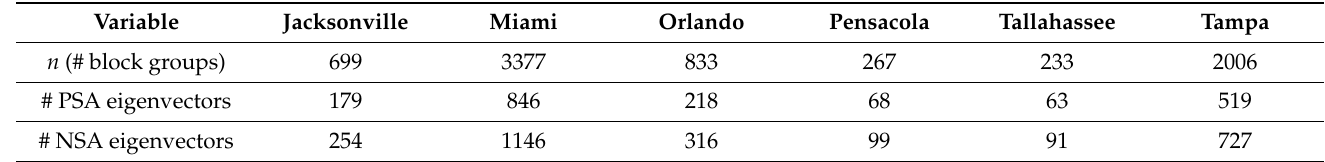
(cid:12) (cid:12) (cid:12) MC j /MC 1 (cid:12) ≥ 0.25.